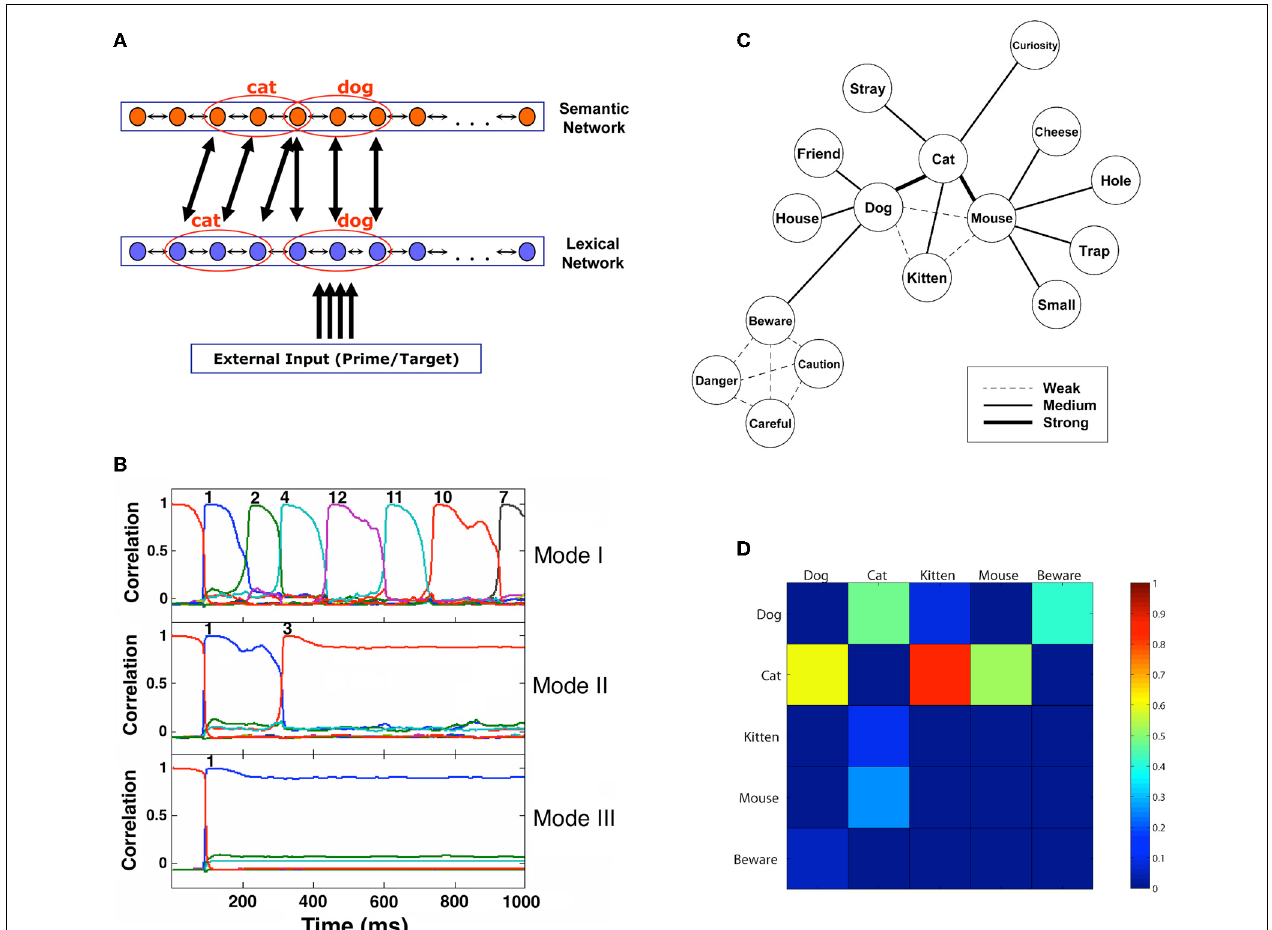
FIGURE 1 | (A) Architecture of the network model. Patterns representing related concepts are correlated in the semantic network but uncorrelated in the lexical network. Active units of two toy example patterns representing “dog” and “cat” are marked. Connections between networks are from active units of a pattern in one network to all the corresponding active units in the other network. For simplicity, only some of these connections are drawn. (B) Correlation of the semantic network state with its stored memory patterns (representing concepts) as a function of time, showing the differences in typical transitions under various noise values. Each pattern is indicated by a curve with a different color (not all correlation curves are visible at all times, as often they coincide). Convergence to a concept is achieved when a correlation reaches a value of 0.95 or above. The network is presented with an external stimulus corresponding to